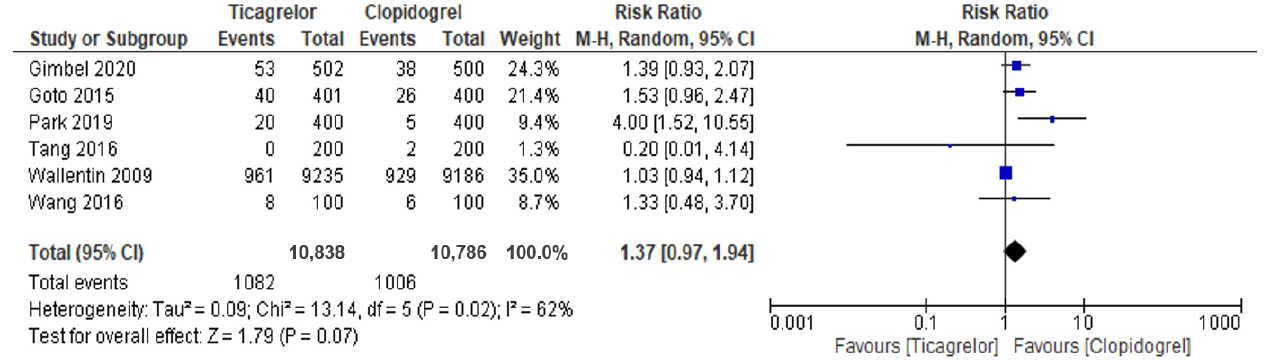
Figure 4. The forest plots for major bleeding in elderly patients treated with Ticagrelor versus clopidogrel.